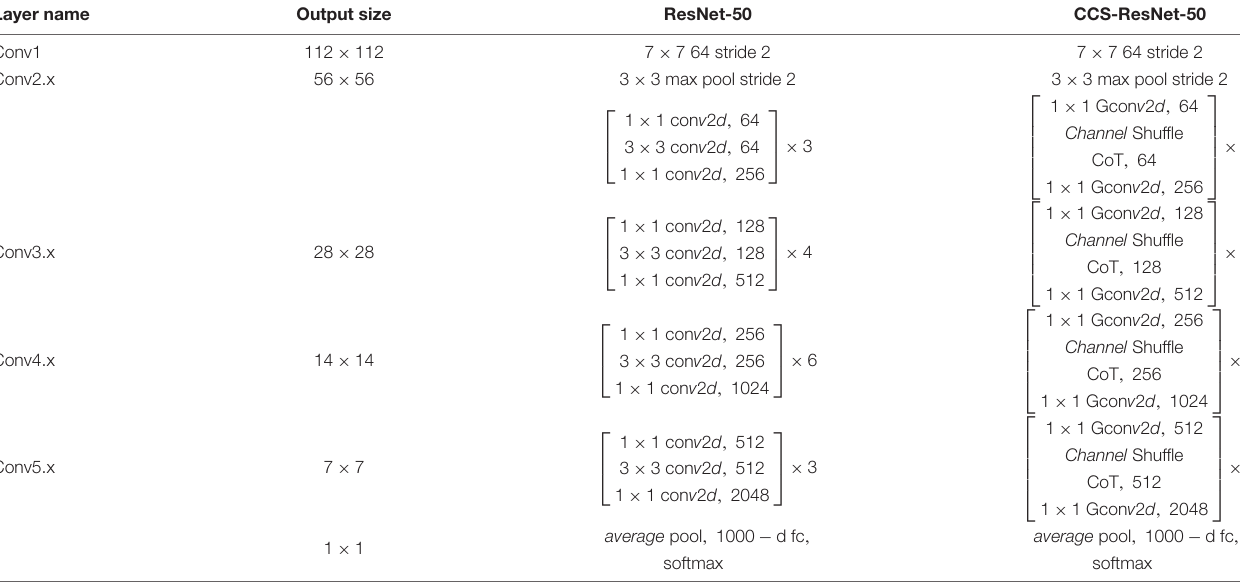
the model as positive class, TN (true negative) indicates the negative samples predicted by the model as negative class, FP (false positive) indicates the negative samples predicted